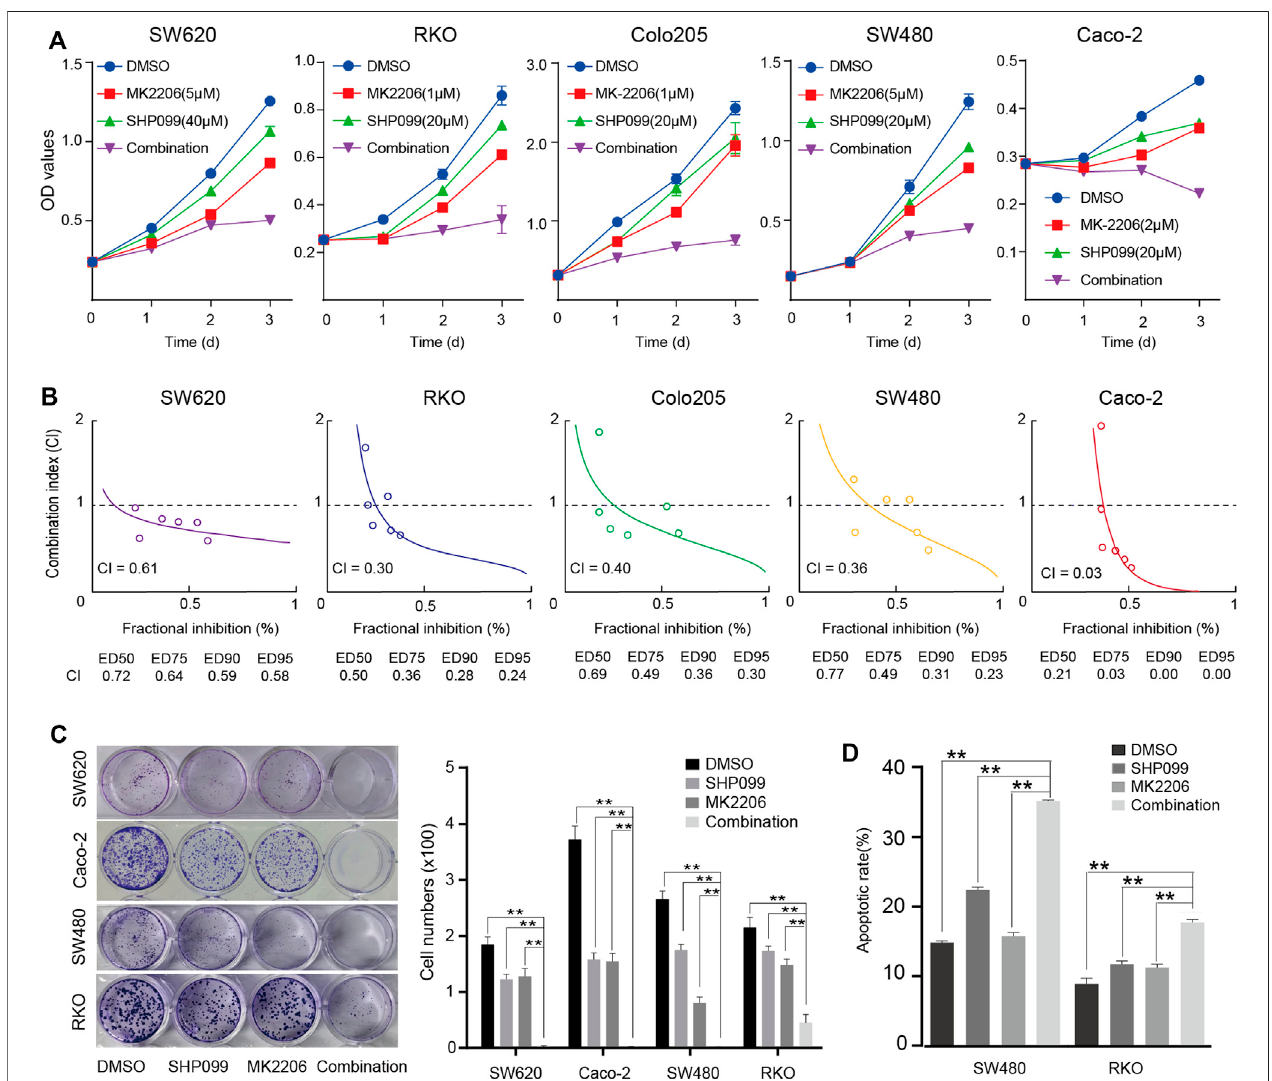
FIGURE 3 | Synergistic suppression effect of SHP099 and MK-2206 on CRC cell growth. (A) The effect of SHP099 and MK-2206 on the proliferation of the 5 indicated cell lines. (B) Combination index of SHP099 and MK-2206 of the 5 involved CRC cell lines. (C) The effect of SHP099 and MK-2206 on the colony formation of the four indicated cell lines. (D) The effect of SHP099 and MK-2206 on the apoptosis of the 2 indicated cell lines. (*** p < 0.001, ** p < 0.01, * p < 0.05).